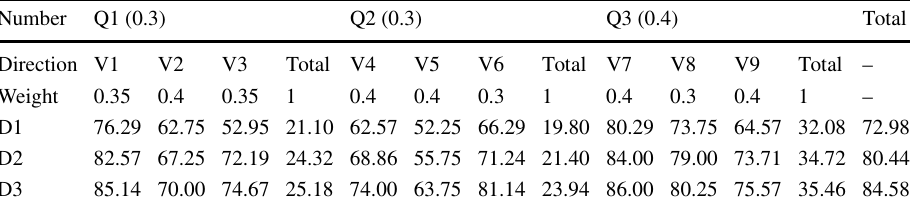
Table 3 Experimental